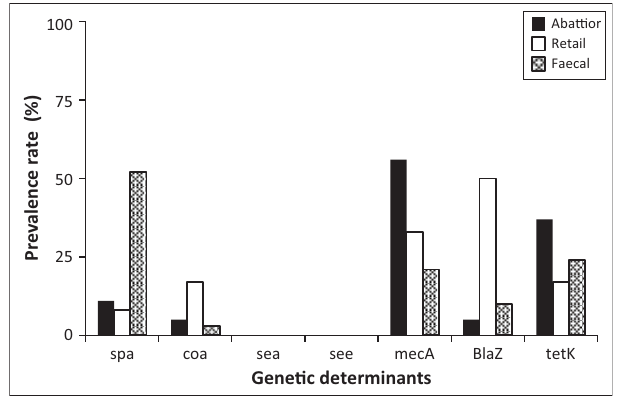
FIGURE 2: Prevalence rates of genetic determinants encoding for virulence and resistance in Staphylococcus aureus